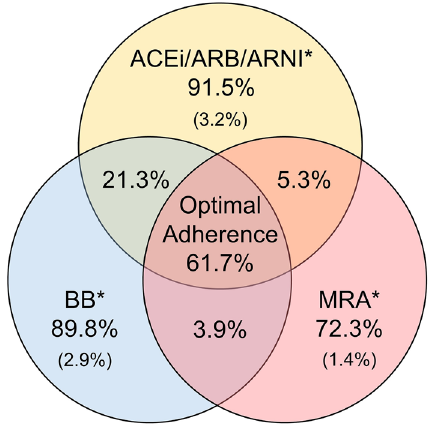
Figure 2. Treatment patterns of guideline-recommended medications at baseline. ACEi, angiotensin- converting enzyme inhibitor; ARB, angiotensin receptor blocker; ARNI, angiotensin receptor-neprilysin